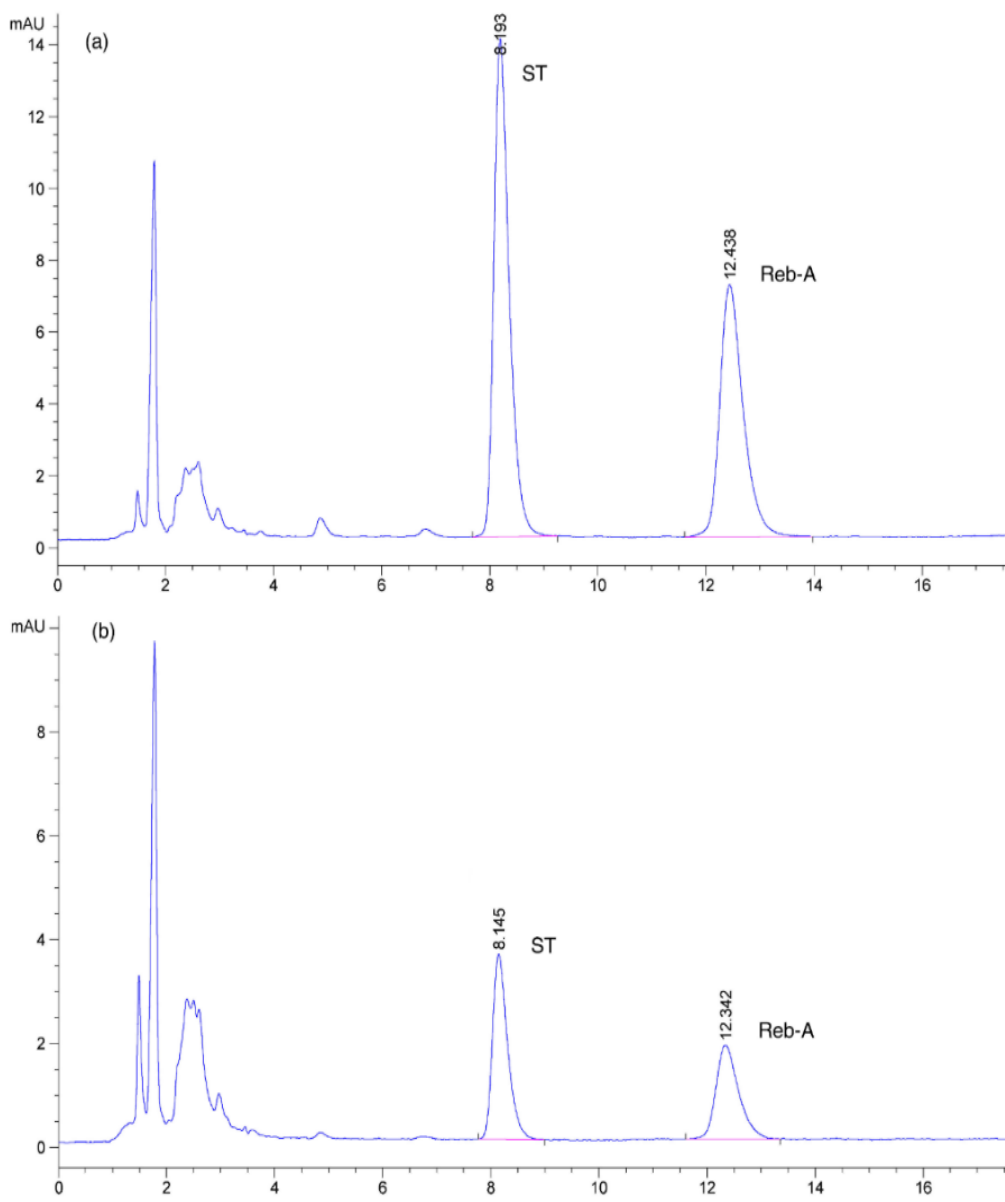
Figure 4 . Standard HPLC chromatograms of quantified glycoside compounds including ST and Reb − A ( a ) and UAE extract ( b ) at optimized process variables of 75% ethanol concentration, 43 min sonication time, and 0.28 g·mL − 1 leaf-to-solvent ratio.